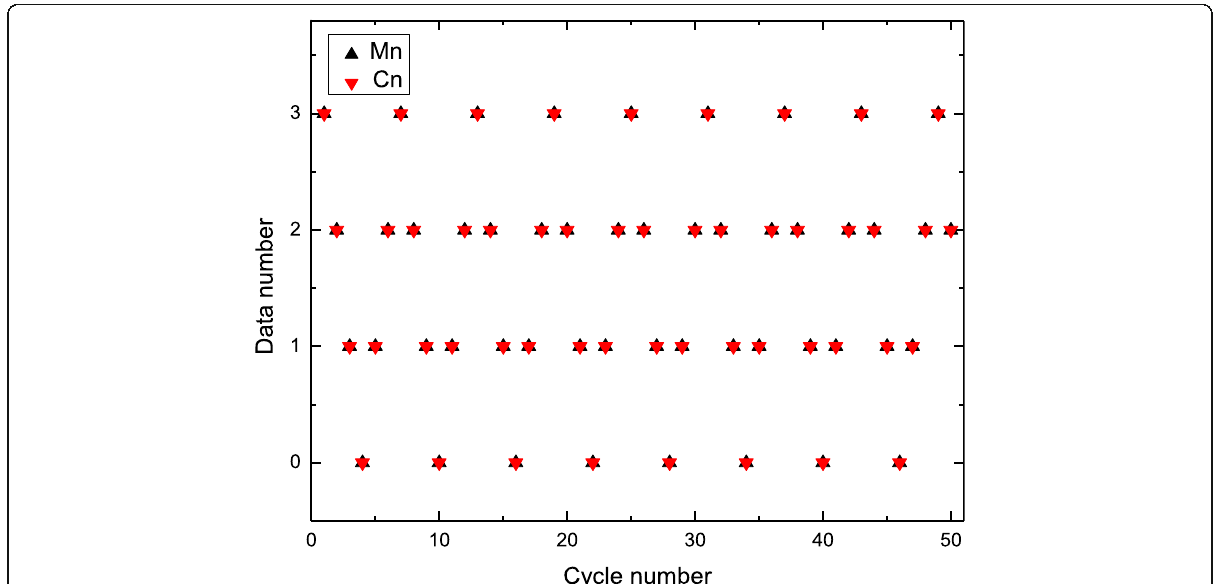
Fig. 22 The total number of periodic data changes increases from 0 to 3; Mn and Cn in the first 50